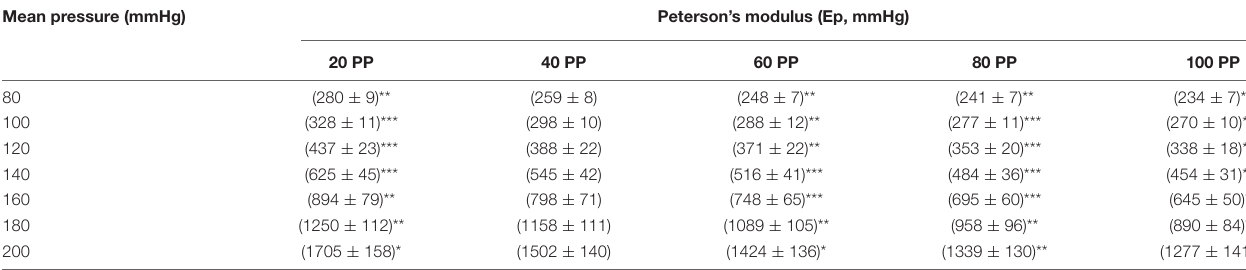
TABLE 1 | Effect of differential pulse pressure on blood vessel stiffness.